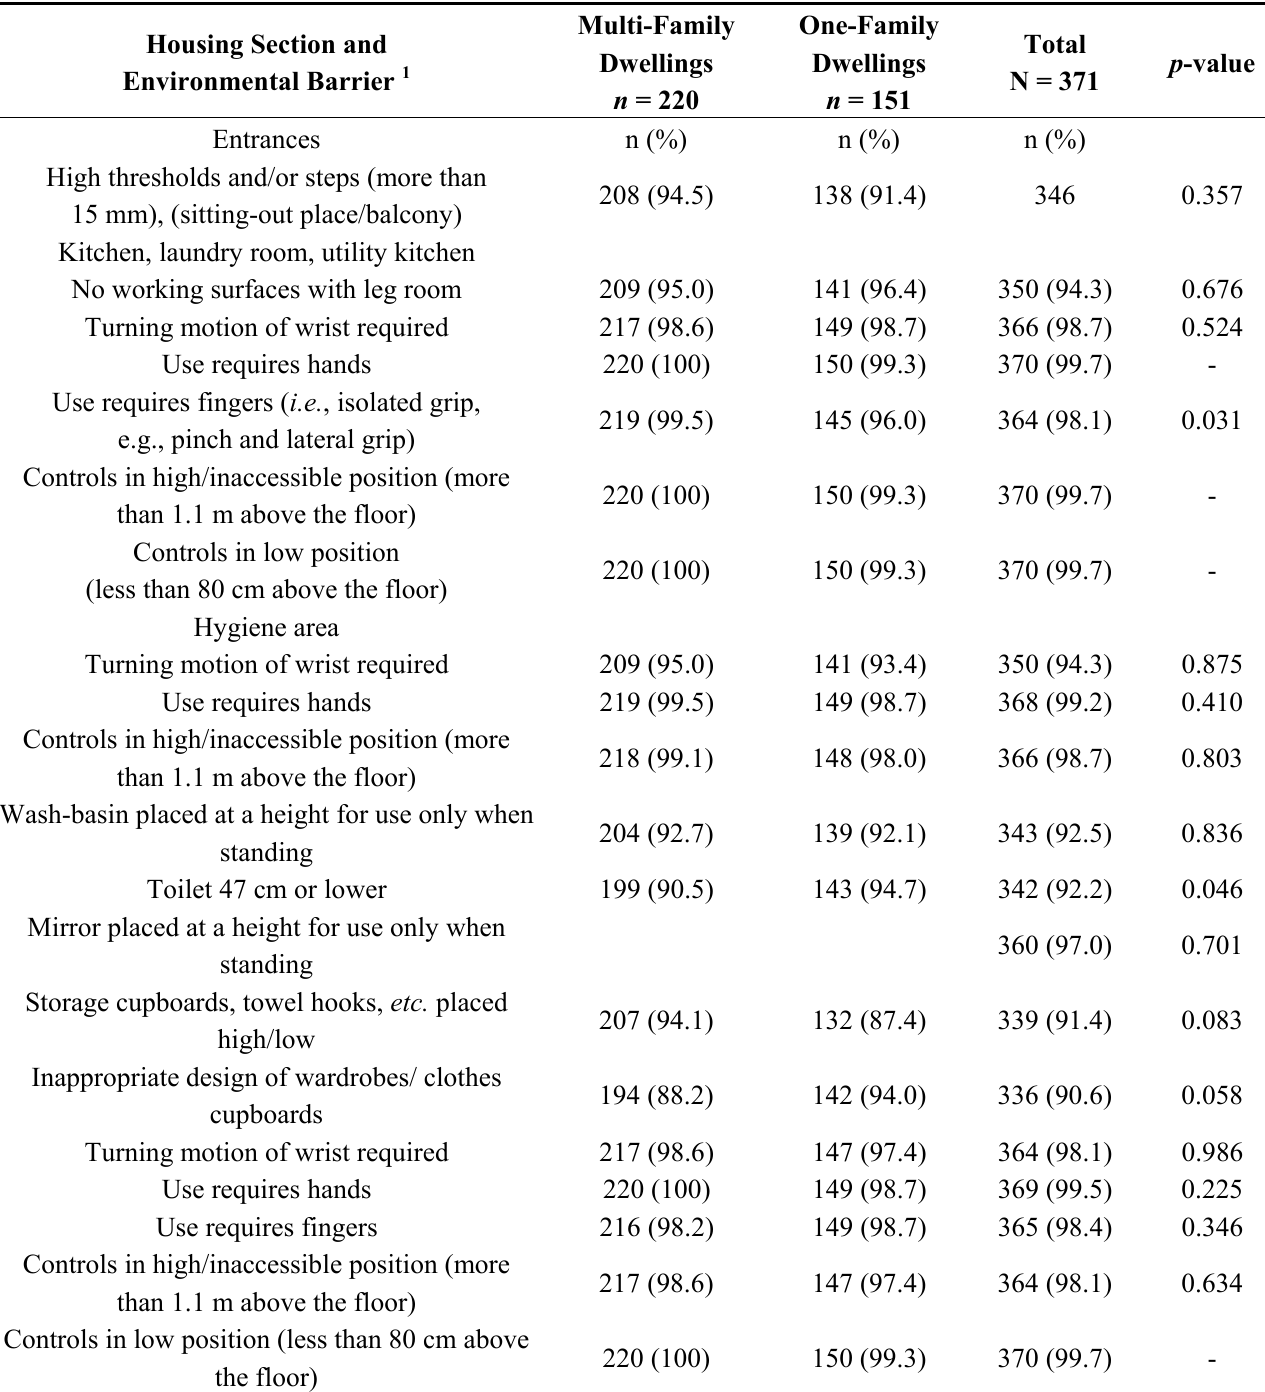
Table 5. The 20 most frequent environmental barriers at entrances and indoors, in different types of housing, N =